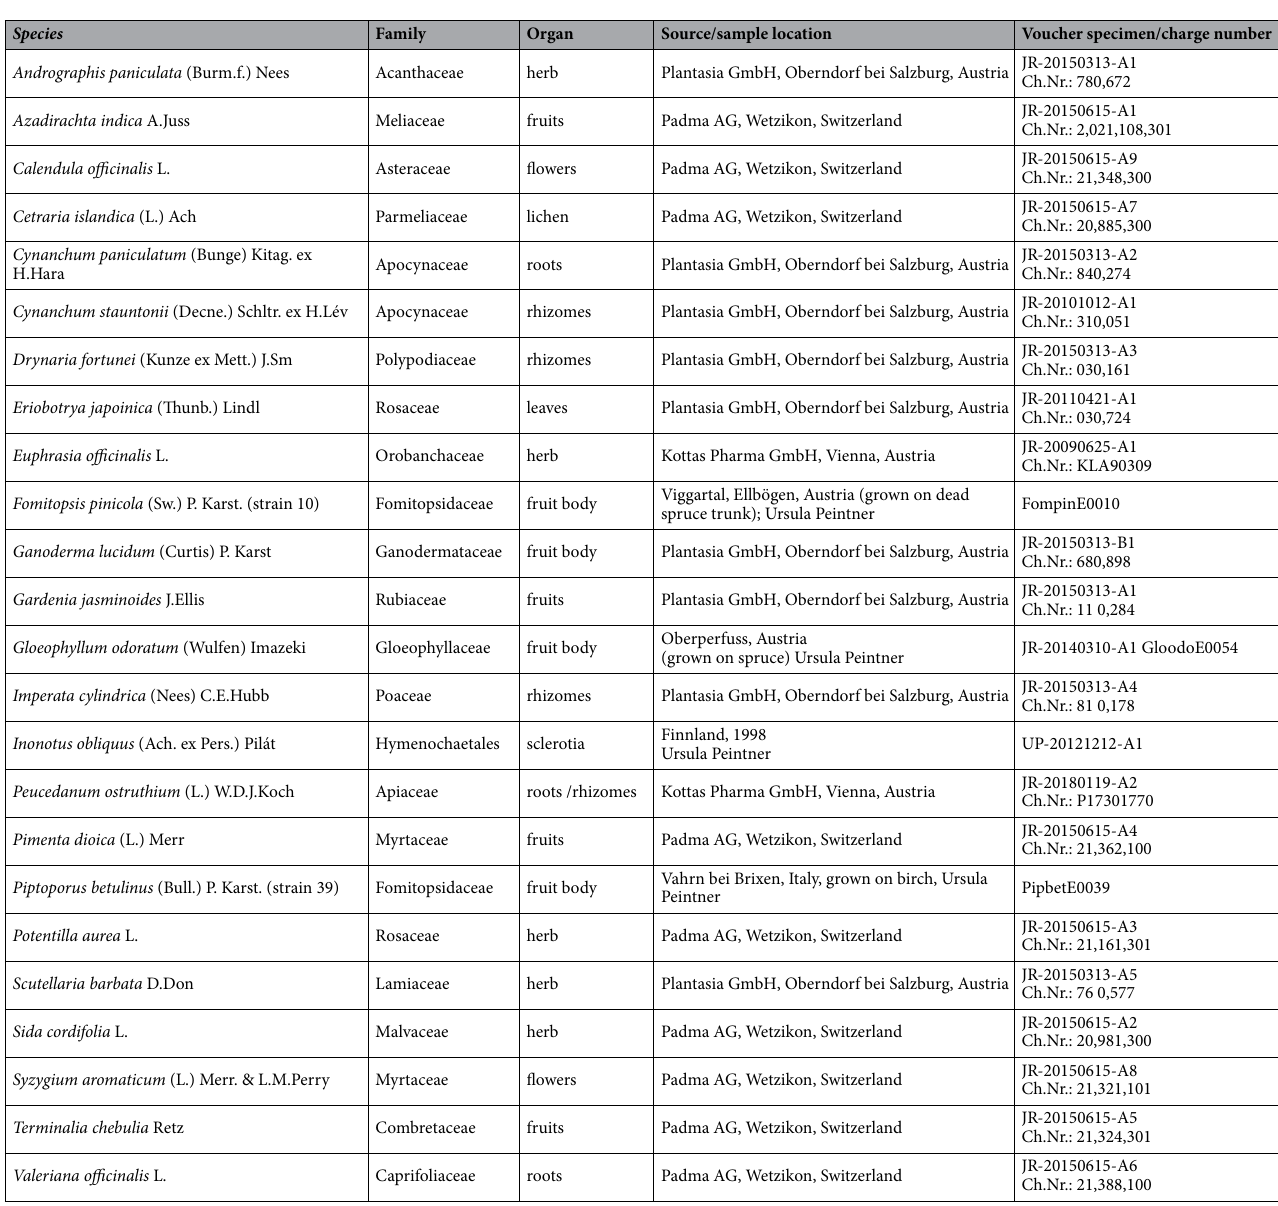
Table 1. Plant and mushroom materials for